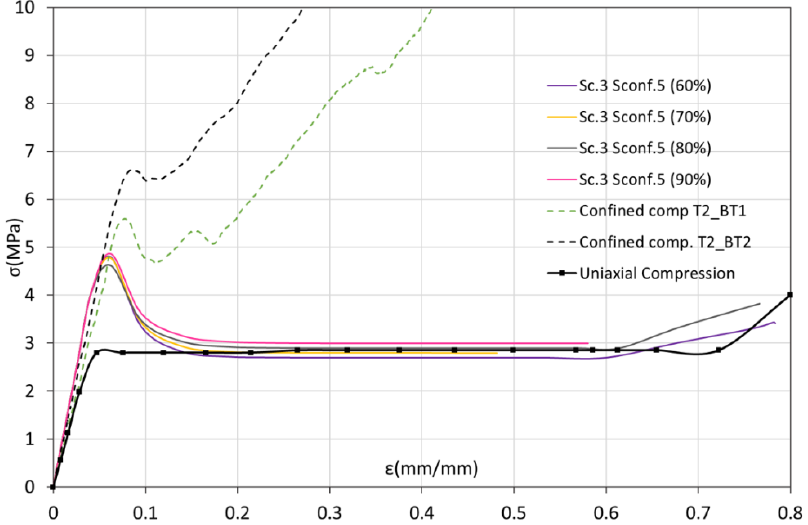
Figure 12. Experimental stress–strain curves (dashed line) vs. numerical (continuous line). Effect of CFV constitutive model parameters in the case of 𝜎 𝑐𝑜𝑛𝑓0 = 5 𝑀𝑃𝑎 .